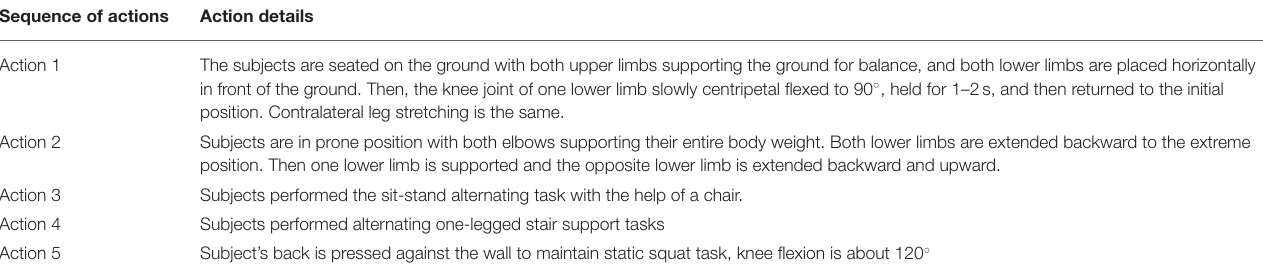
TABLE 2 | Details of the operation of stretching training exercise